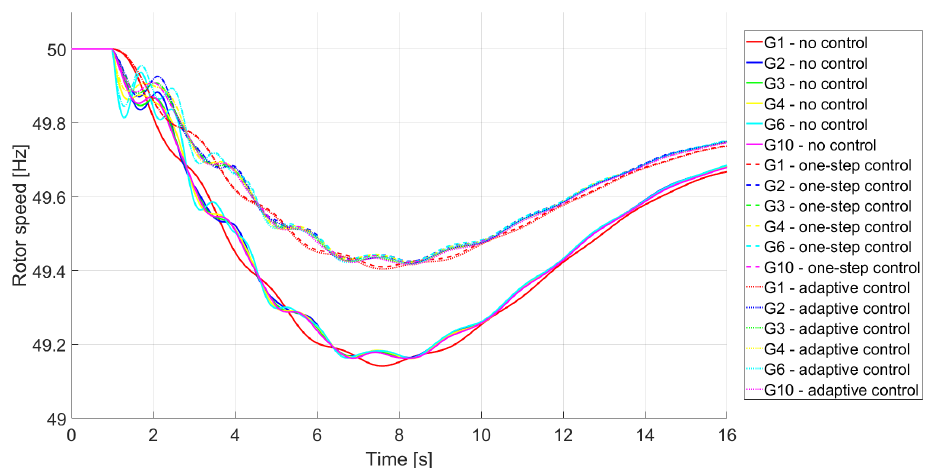
Figure 14. Generators’ rotor speed in Configuration I in case of small disturbance.